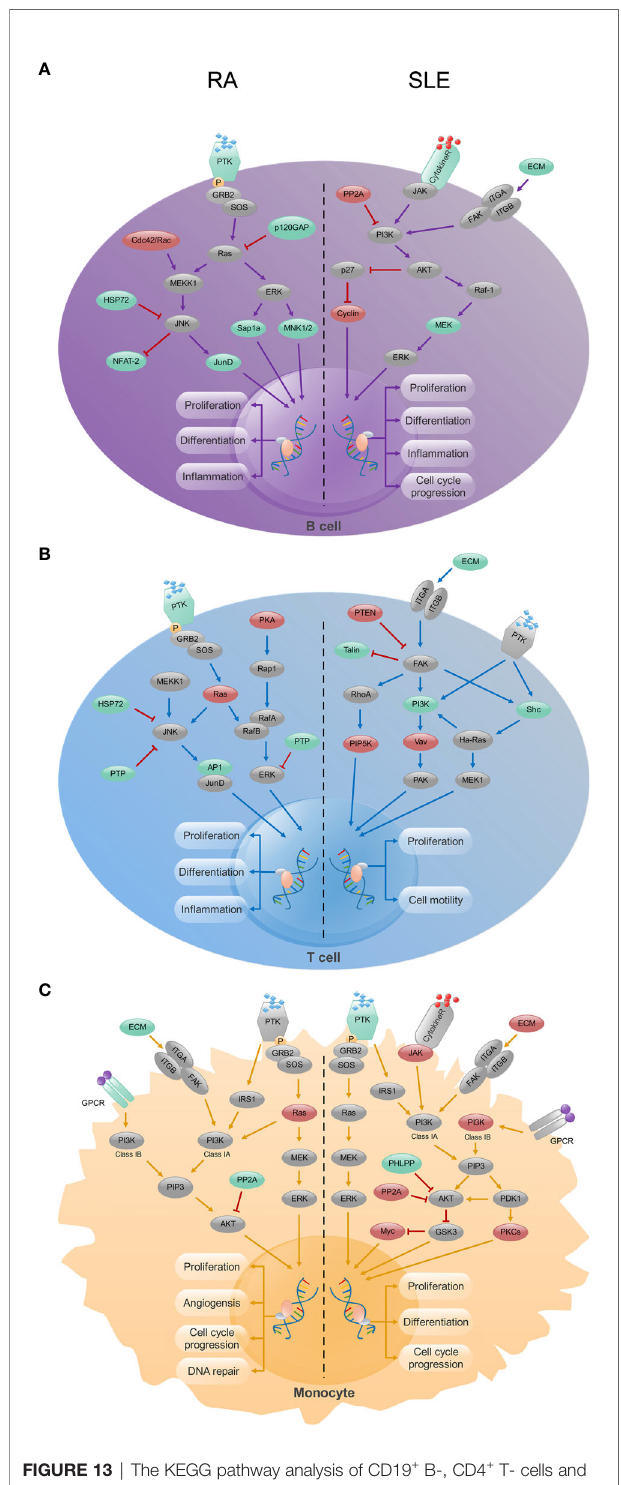
FIGURE 13 | The KEGG pathway analysis of CD19 + B-, CD4 + T- cells and CD14 + monocytes in RA and SLE. (A) In CD19 + B cells, MAPK and PI3K signaling pathways were enriched in RA and SLE, respectively. (B) In CD4 + T cells, MAPK and focal adhesion signaling pathways were enriched in RA and SLE, respectively. (C) PI3K signaling pathway was enriched in CD14 + monocytes from both RA and SLE. Up-regulated, down-regulated and unchanged genes are marked in red, green and gray colors,